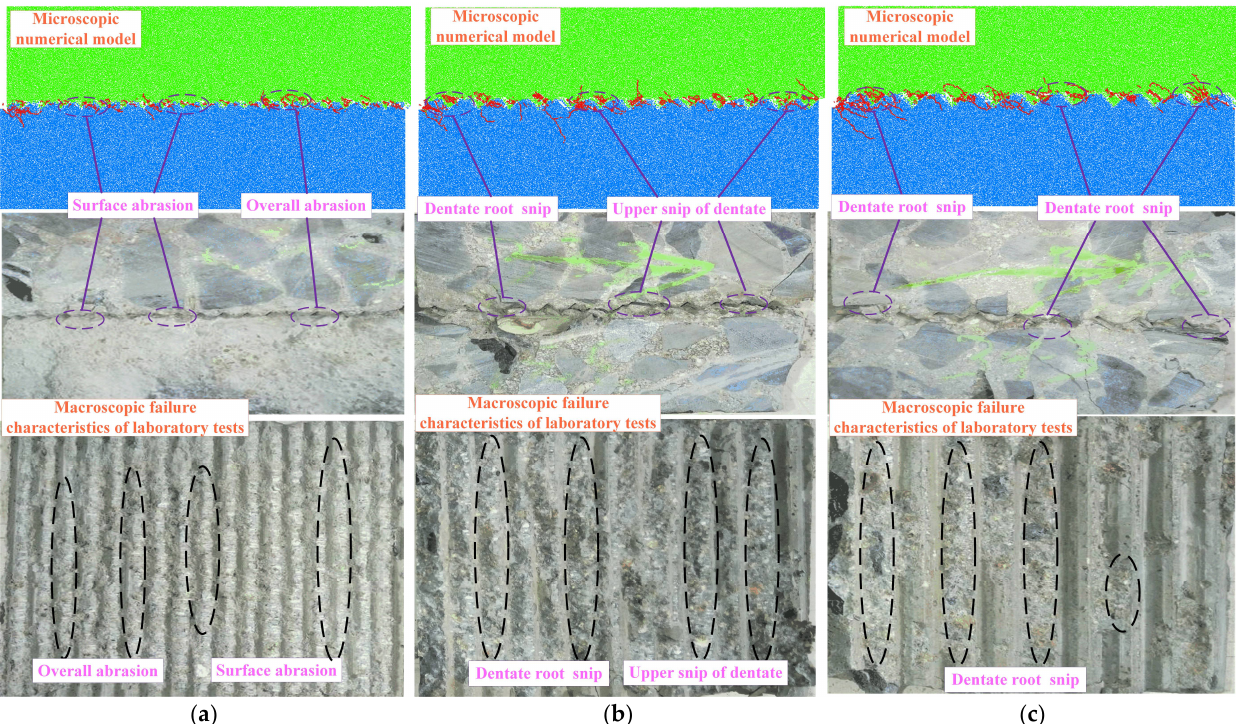
Figure 12. Comparison of shear failure characteristics of joints with different roughness: ( a ) rough- ness r = 0.17; ( b ) roughness r = 0.30; ( c ) roughness r = 0.37. r = 0.17; ( b ) roughness r = 0.30; ( c ) roughness r =